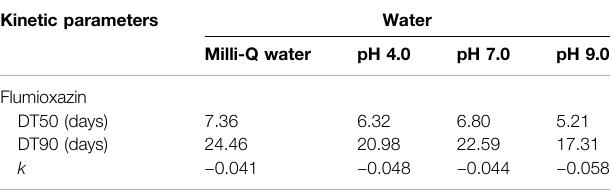
TABLE 6| Kinetic parameters forphotocatalyticdecontaminationof fl umioxazinin water under direct sunlight Kinetic